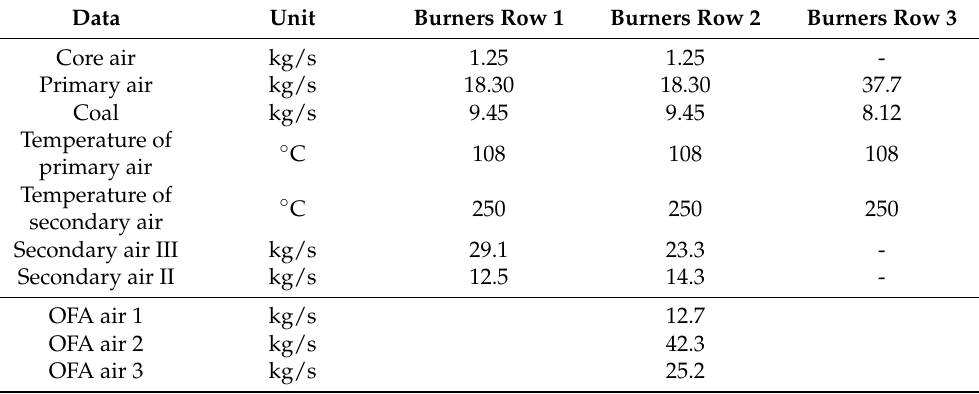
Table 1. Distribution of air and fuel to the boiler.